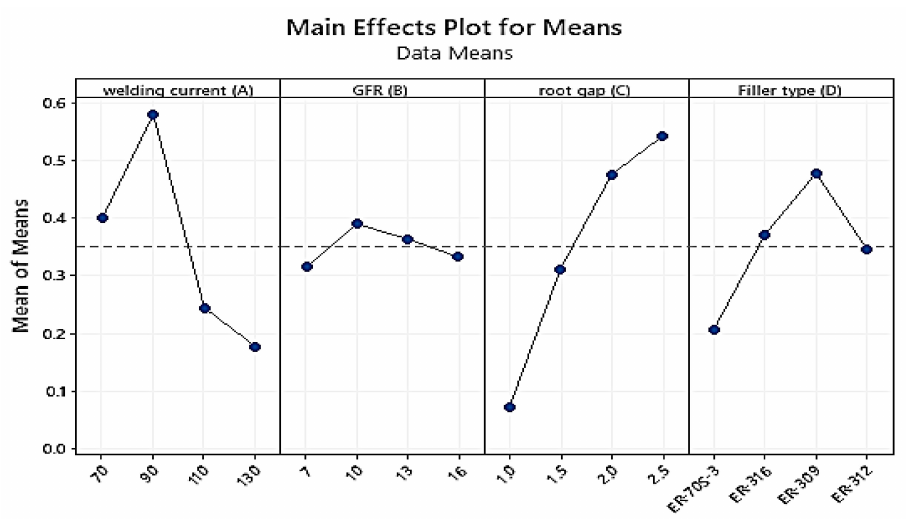
Figure 23. Main effect plot for means of CDI